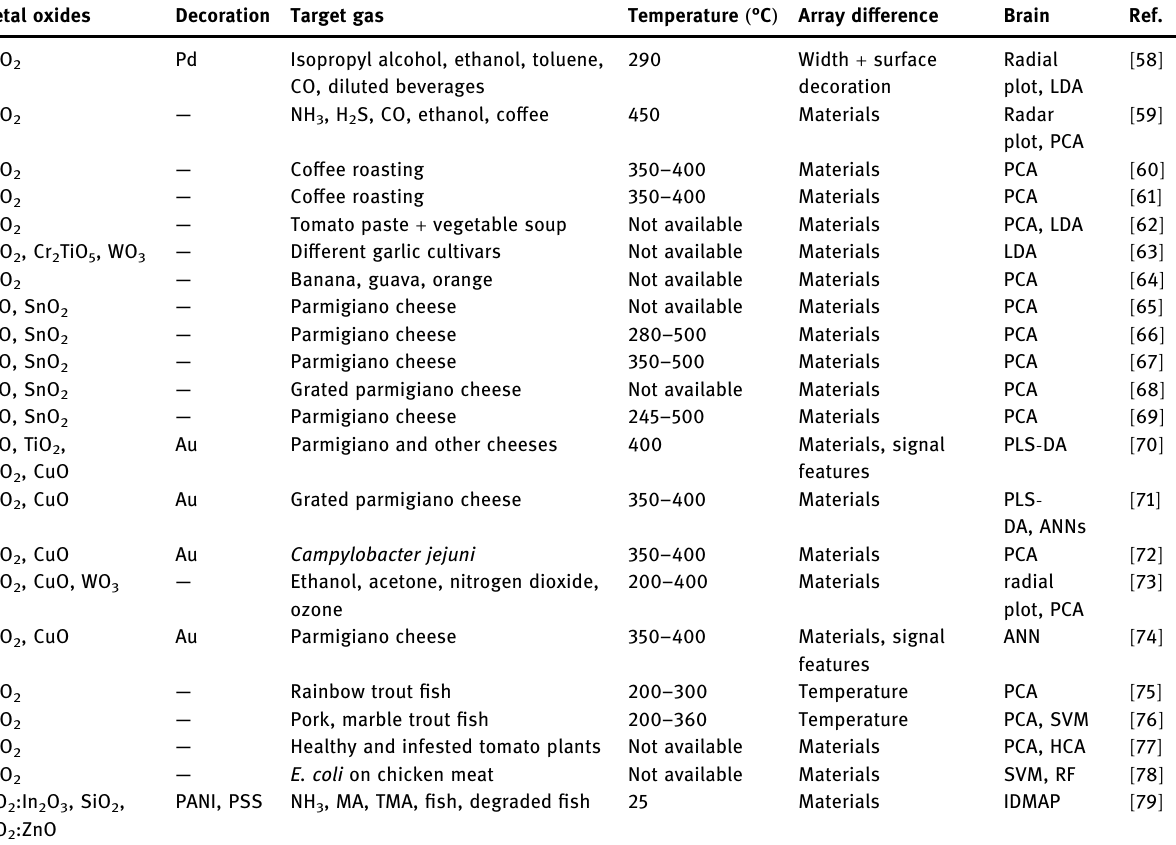
Table 2: List of scienti fi c papers on electronic noses based on metal oxide nanowires applied to agrifood products Metal